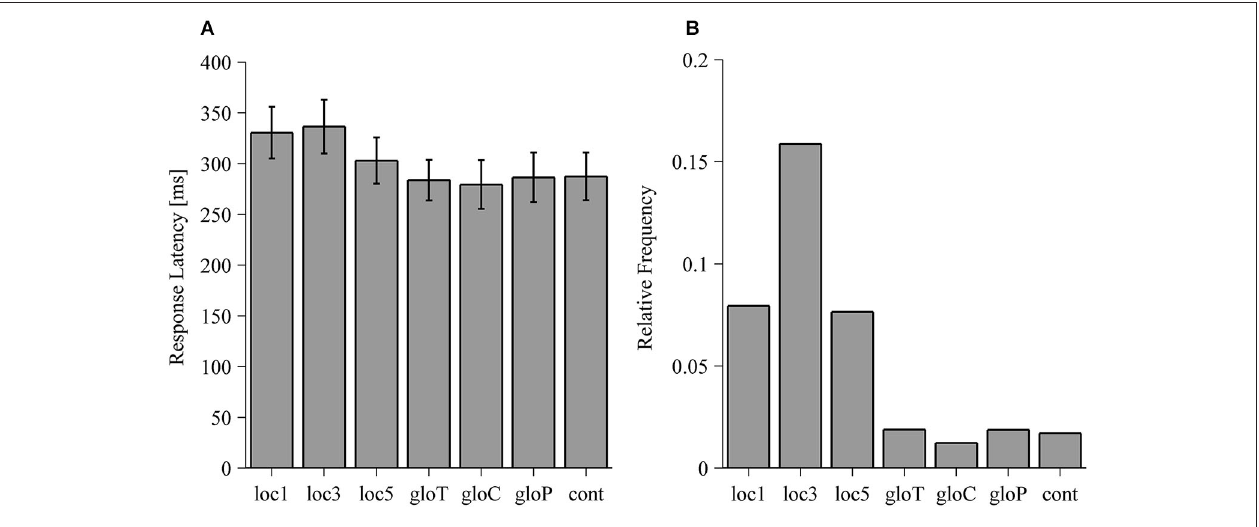
participants with no reach response for the local, global and control (cont) conditions. For each condition, the relative frequency is computed as the amount of trials without a reaching response divided by the total amount of trials in that